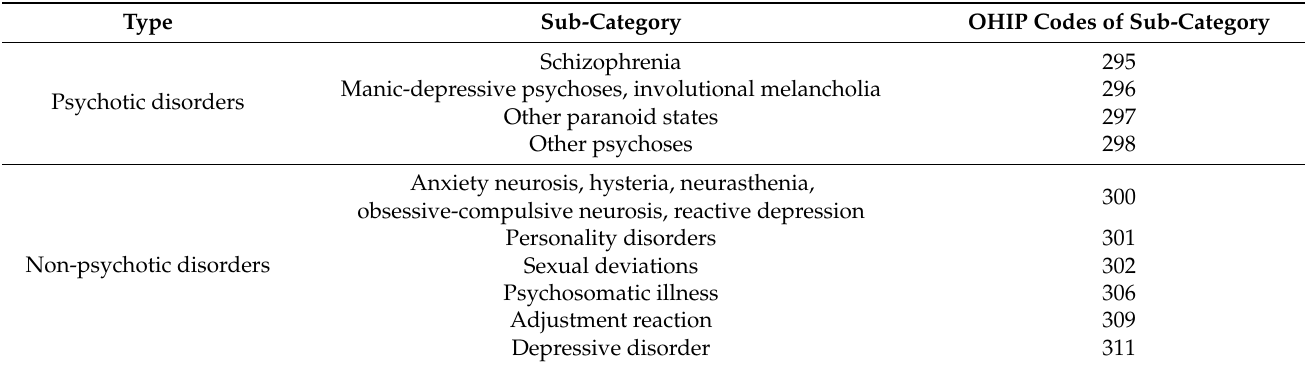
Table 1. Categories and sub-categories of mental health disorders used in this